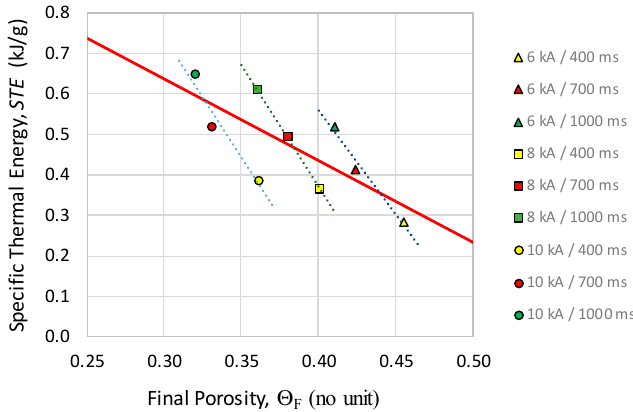
Figure 8. Final porosity ( Θ F ) versus Specific Thermal Energy ( STE ) for the different MF-ERS compacts.